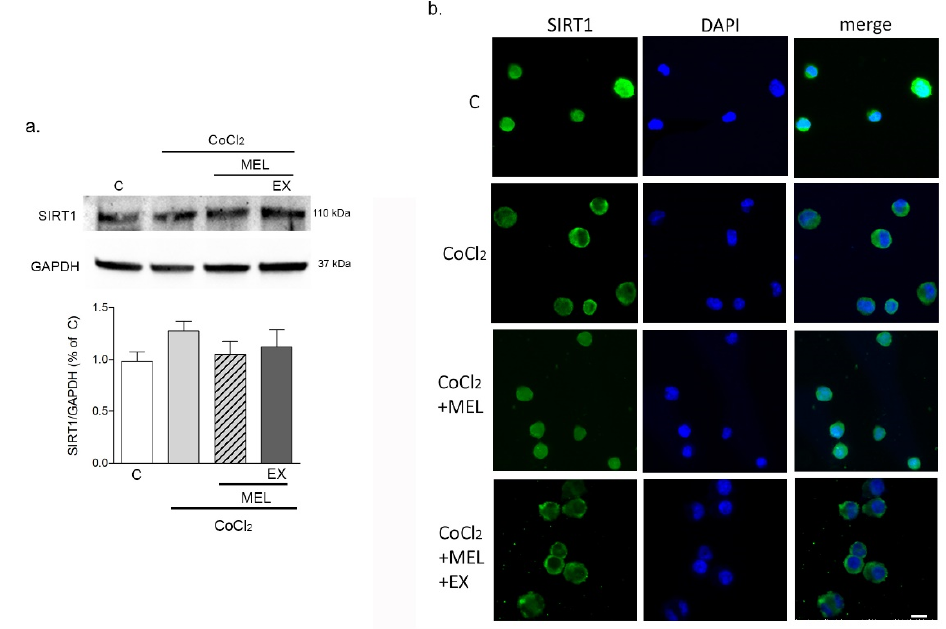
Figure 4. CoCl 2 prevents SIRT1 nuclear translocation in microglia. In ( a ), Western blot analysis of SIRT1 expression in BV2 cells exposed to CoCl 2 (250 µ M for 8 h) alone, or in combination with either melatonin (1 µ M) or melatonin + EX527 (5 µ M). In ( b ), immunostaining of SIRT1 (green) and nuclear counterstaining with DAPI (blue) in BV2 cells treated with CoCl 2 alone or in combination with melatonin (1 µ M) or melatonin + EX527 (5 µ M). Bars are mean ± SEM of three independent experiments. Representative images are shown. Scale bar = 20 µ